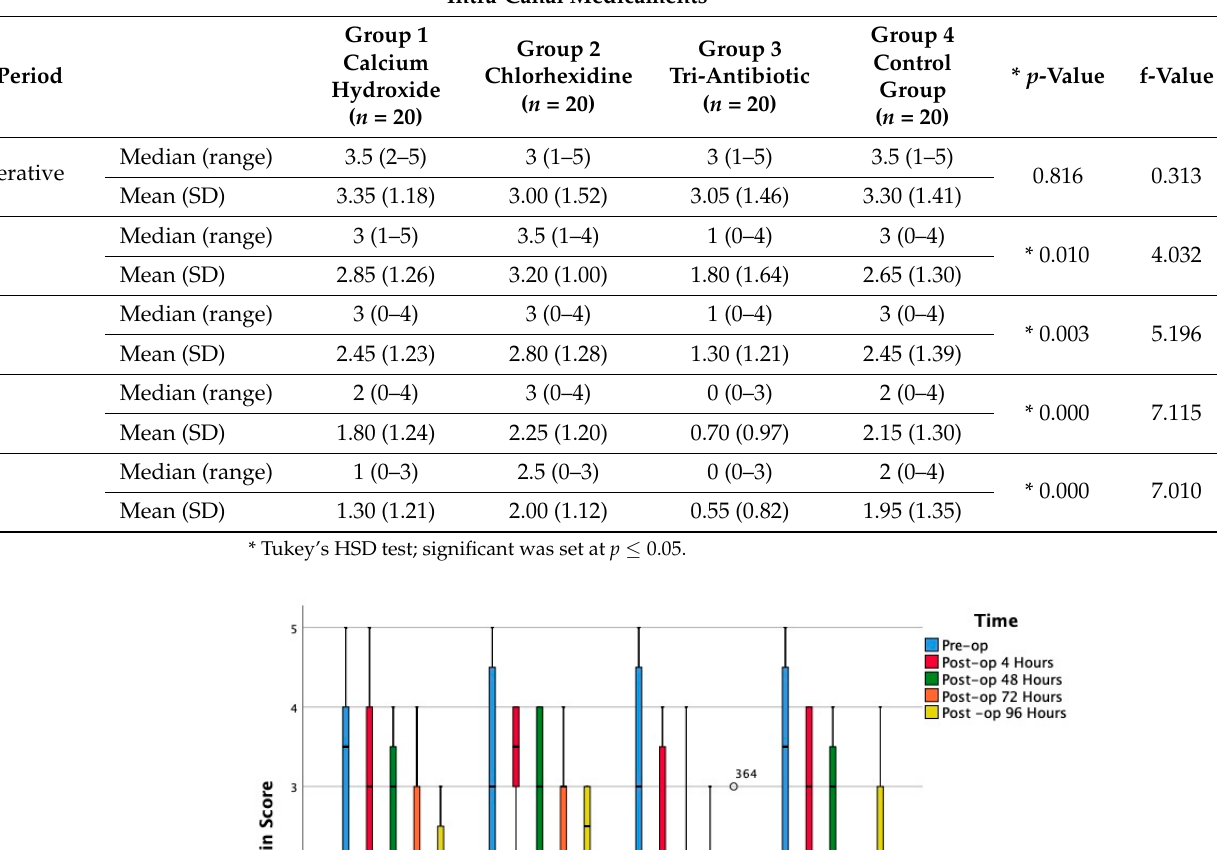
Table 1. descriptive statistics of study sample.